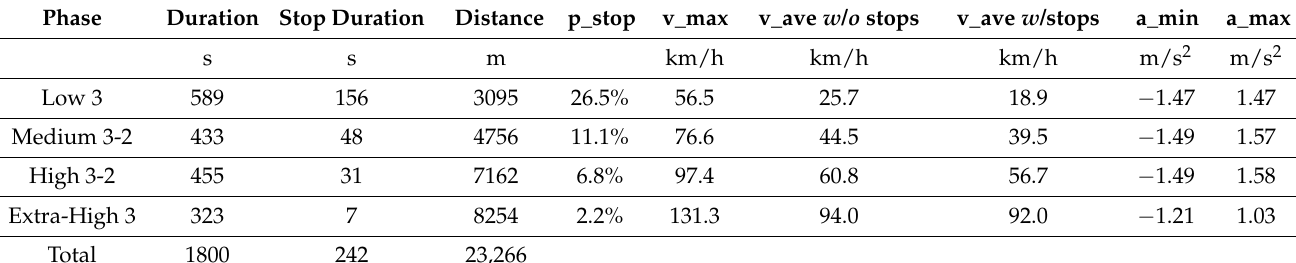
Table 3. WLTC Class 3b (v_max ≥ 120 km/h)